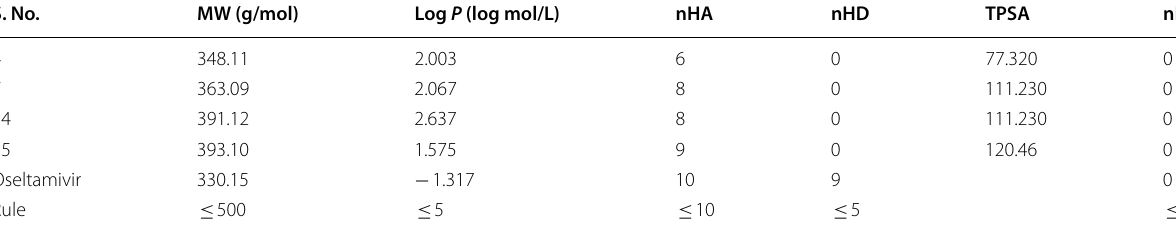
Table 15 Lipinski’s rule of the lead compounds in the dataset S. No.